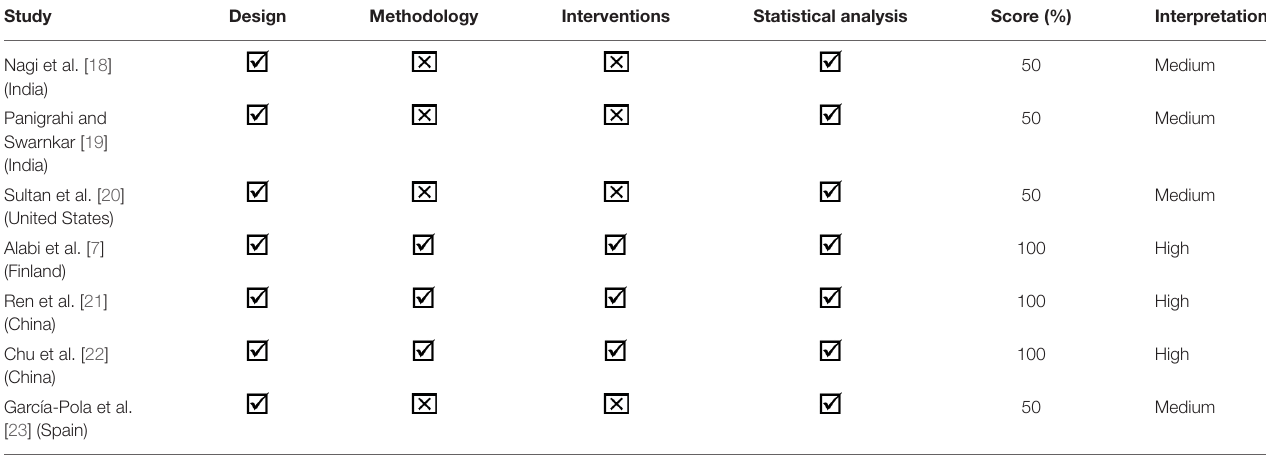
TABLE 1 | The quality appraisal of the included systematic